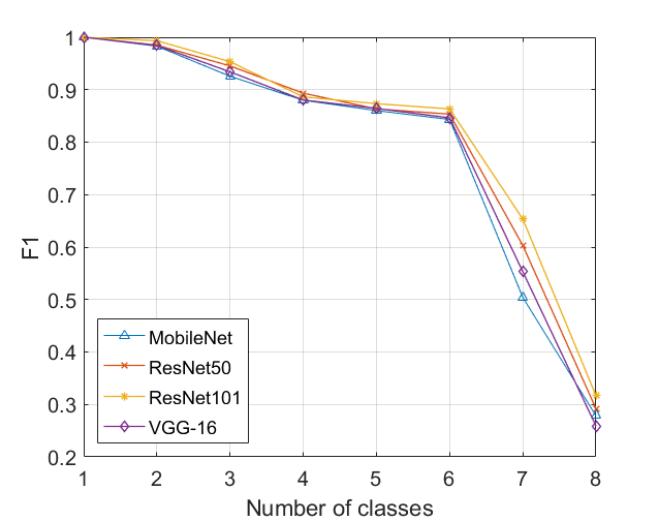
Figure 4. Incremental classification performance in terms of the F1-score on